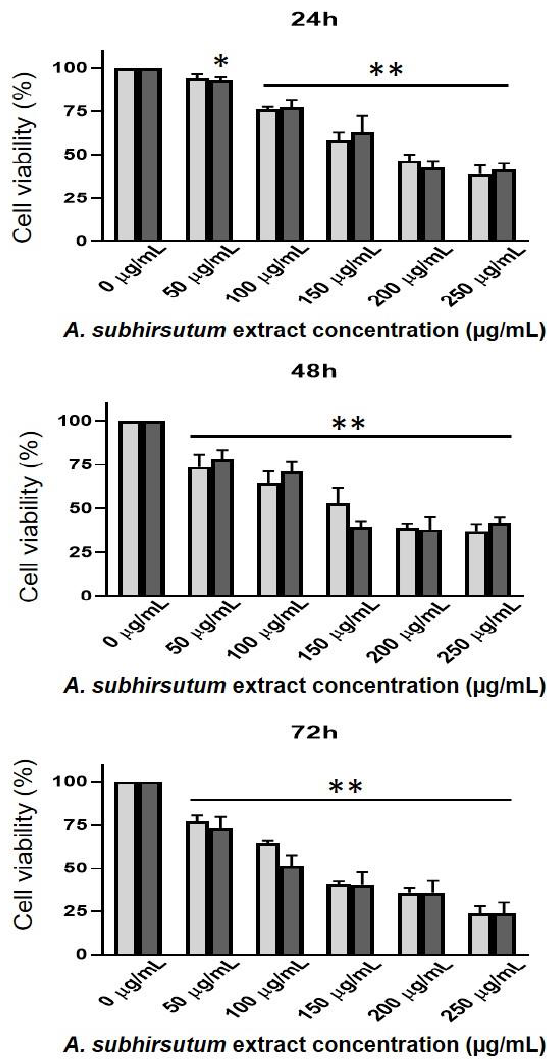
Figure 3. Time course and dose-response effects of Allium subhirsutum methanolic extract at different doses: 0, 50 and 100 µg/mL, on Walker 256/B and MatLyLu cells’ vitality. The cells were incubated for 24, 48 and 72 h. Cell viability was assessed using the MTT assay. Pure (100%) EthO was used as a positive control. Note that the effect is dose- and time-dependent. The most prominent effect was noticed at 72 h with the highest dose (250 µg/mL). Values represent mean ± standard deviation (SD) of n = 3. Statistical difference between the groups * p < 0.05, ** p < 0.01 following one-way analysis of variance (ANOVA) and Newman–Keuls post hoc tests. The experiment was run in